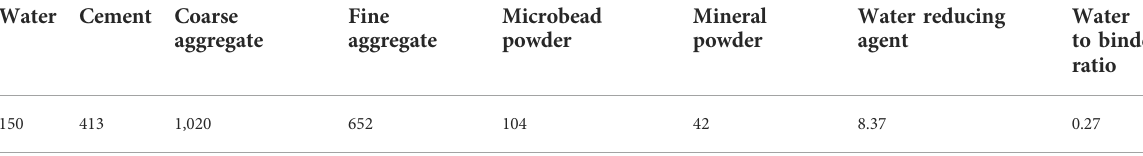
TABLE 4 Mix proportion of commercial self-compacting concrete (Unit: kg/m 3 ).